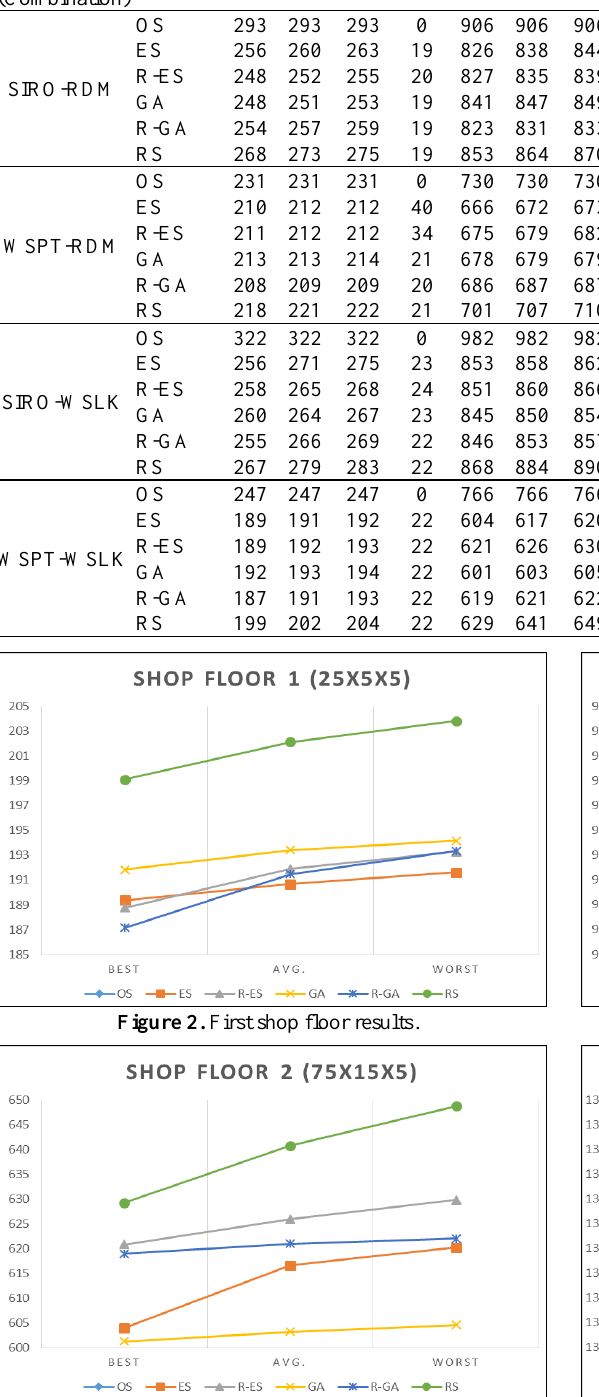
Figure 3. Second shop floor results.